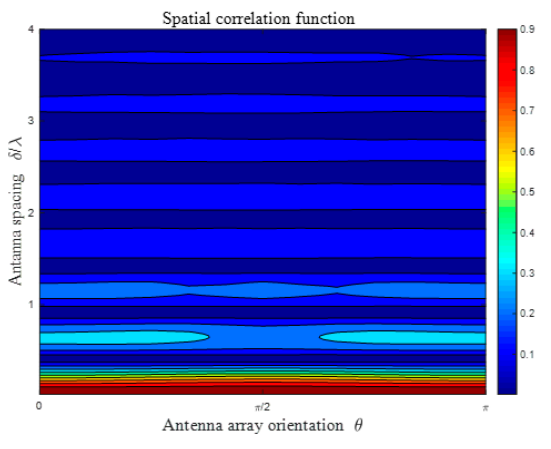
Figure 6. Analytical results of the spatial CF ρ pq , p’q’ ( δ T , δ R ) of the proposed model in an isotropic scattering environment for different antenna spacings δ / λ and different antenna array orientation maximum ranges of elevation angle θ .